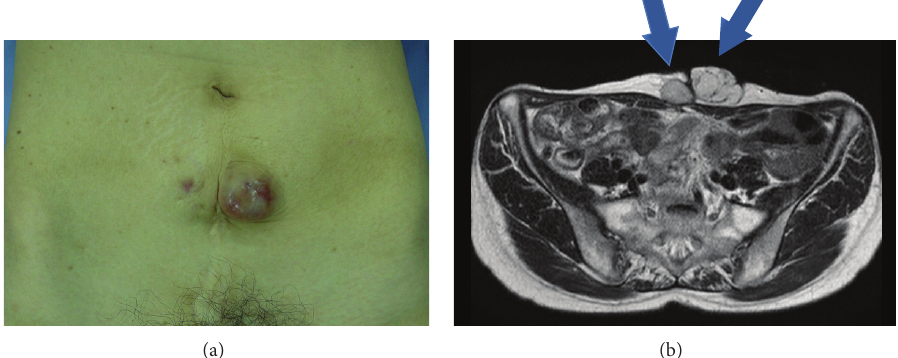
Figure 1: (a) Smooth mass on the middle-left side of the cesarean median scar. (b) Pelvic MRI (T2 weighted image, axial section). MRI shows the tumor associated with cesarean section scar. The right side of the scar consists of solid components and the tumor at the left side of the scar is polycystic.